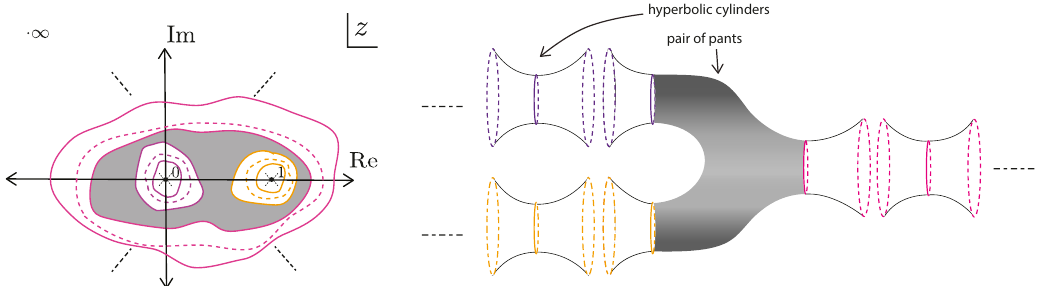
Figure 1 . Sketch of the hyperbolic metric described by the Fuchsian equation with three hyperbolic singularities. The smooth hyperbolic pair of pants with geodesic boundaries is going to connect the hyperbolic cylinders, as we shall see more